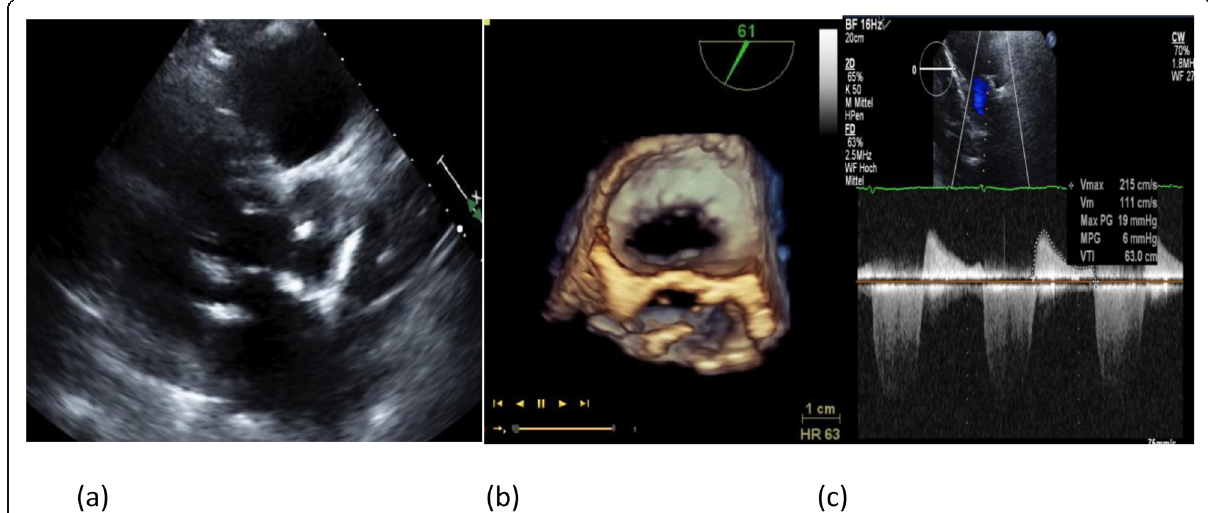
Fig. 5 2D TTE showed annular calcification ( a ). Even though the mitral valve area was more than 3 cm 2 in 3D ( b ), the mean gradient after the first clip was 6 mmHg with residual MR ( c